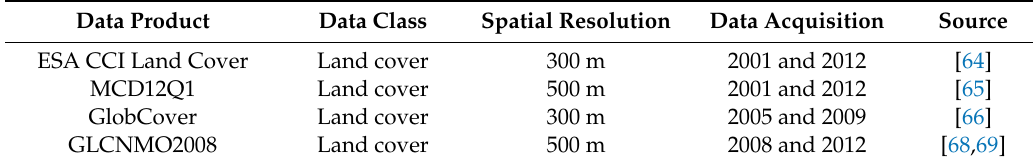
Table 2. Product specification of global land cover (GLC)